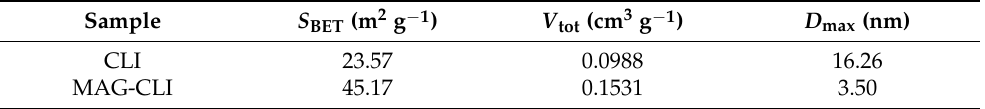
Table 3. Textural properties of CLI and